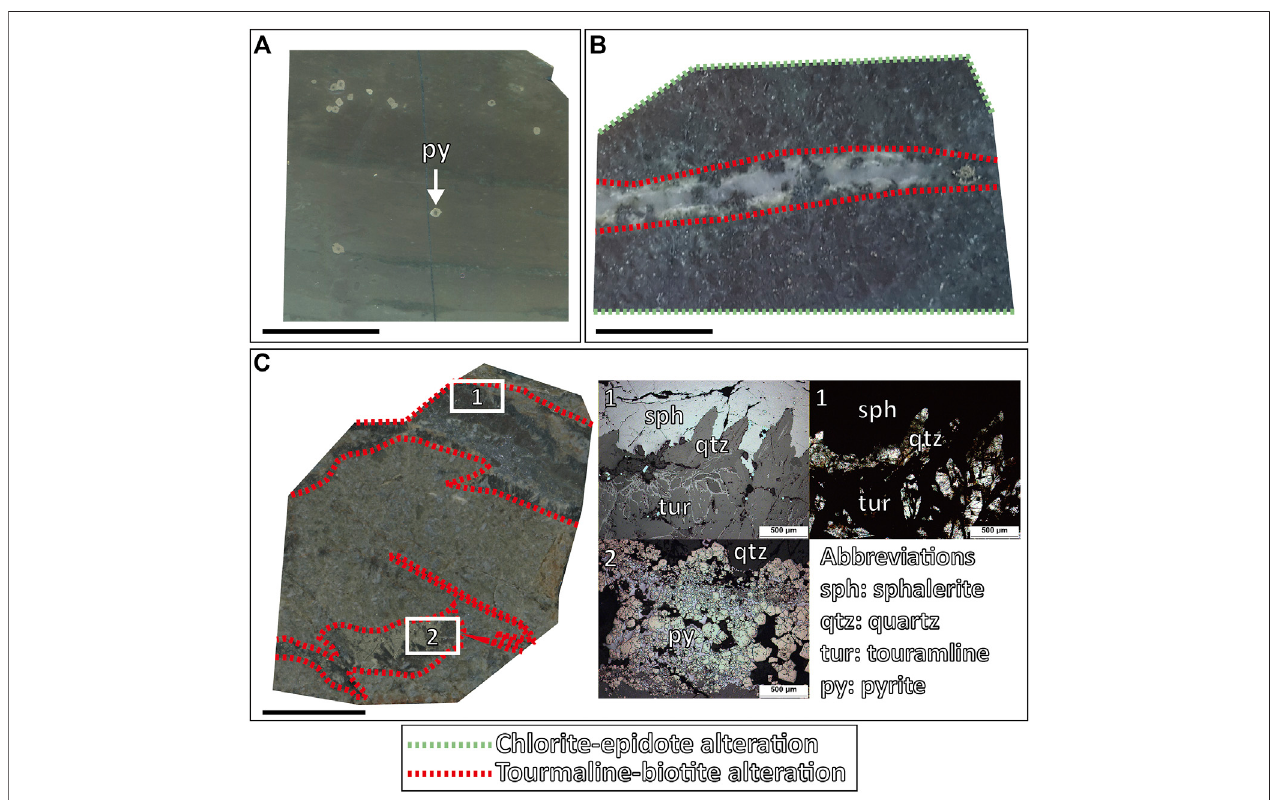
FIGURE 5 | Vein and alterations petrography of the Daejang deposit. (A) Pyrite grains are present in hornfels. (B) Tourmaline-(K-feldspar)-biotite alterations are shownalongthequartzveinscuttingthechlorite-epidotealteredhostrock. (C) Tourmaline-biotitealterationsformedalongthequartzveins.(C-1)Tourmaline,sphalerite, quartz, and (C-2) pyrite images obtained by re fl ected (left) and transmitted light (right) microscopy. The green dotted lines represent a chlorite-epidote “ CE ” alteration, and the red dotted lines represent a tourmaline-(magnetite)-biotite “ TB ” alteration.